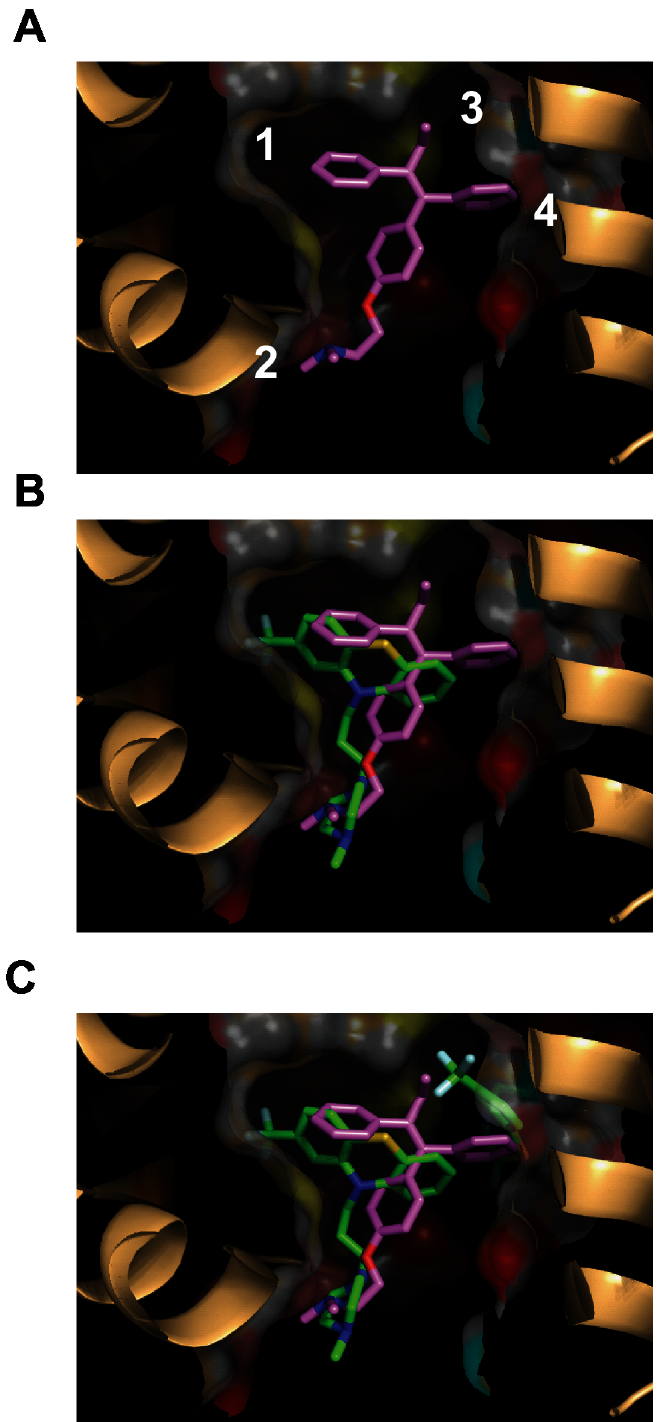
Fig 6. Model of tamoxifen binding to Cryptococcus neoformans calmodulin. As described in the materials and methods, a homology model of C . neoformans calmodulin bound to tamoxifen was built based on the structure of the bovine calmodulin-trifluoperazine complex [25]. A. Binding of tamoxifen to the trifluoperazine binding pocket. The numbers are arbitrary indicators of the four regions of the binding pockets described in the text. B. Overlay of tamoxifen with one molecule of trifluoperazine in the binding pocket. C. Overlay of tamoxifen with binding pocket containing both molecules of trifluoperazine.